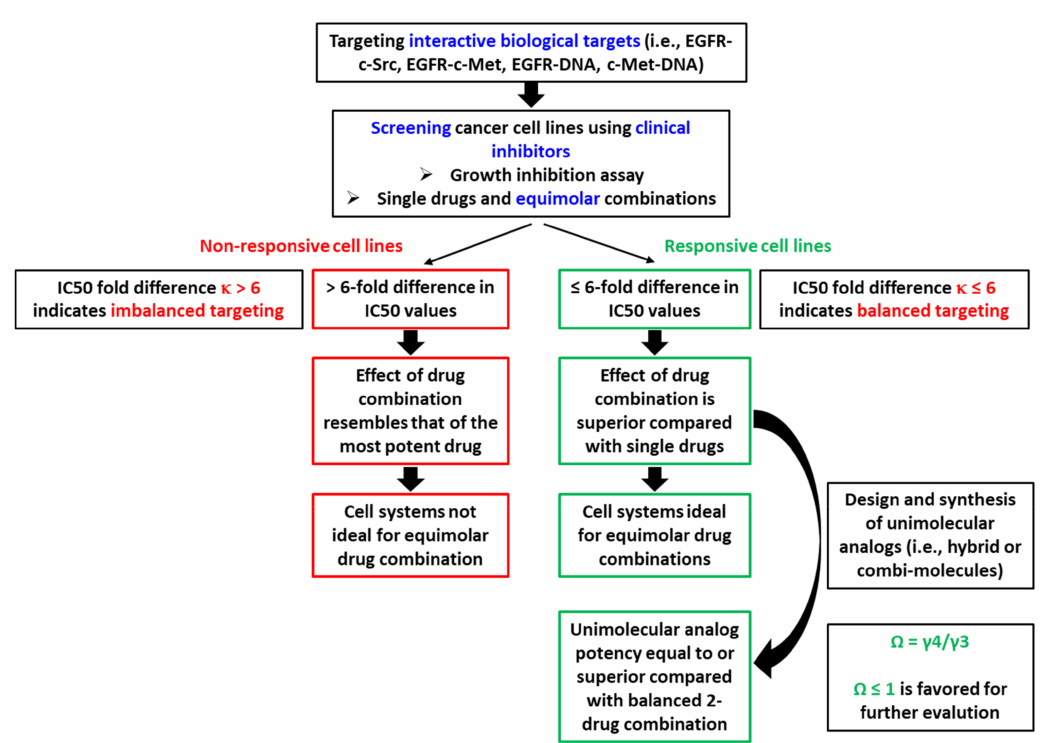
Figure 6. Flow chart summarizing the sequence of events leading to the design and synthesis of unimolecular analogs (i.e., hybrid drugs, chimeric molecules, and combi-molecules) as predicted on the basis of the fold difference between individual drugs ( κ ). γ 1 = IC50 of drug 1, γ 2 = IC50 of drug 2, γ 3 = IC50 of equimolar combination of drug 1 + drug 2, γ 4 = IC50 of unimolecular analog (e.g., combi-molecule), κ = γ 1/ γ 2 where γ 1 > γ 2, and Ω = combi-targeting effect of unimolecular analog calculated using the equation Ω = γ 4/ γ